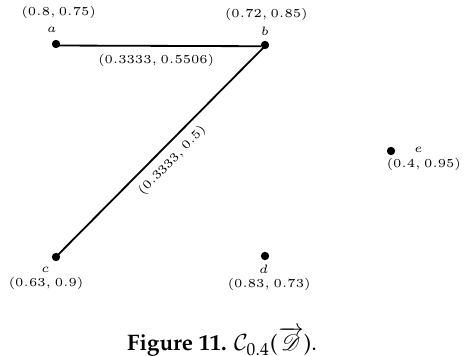
( −→ D ( −→ D ) 0 . 4 C 0.4 C